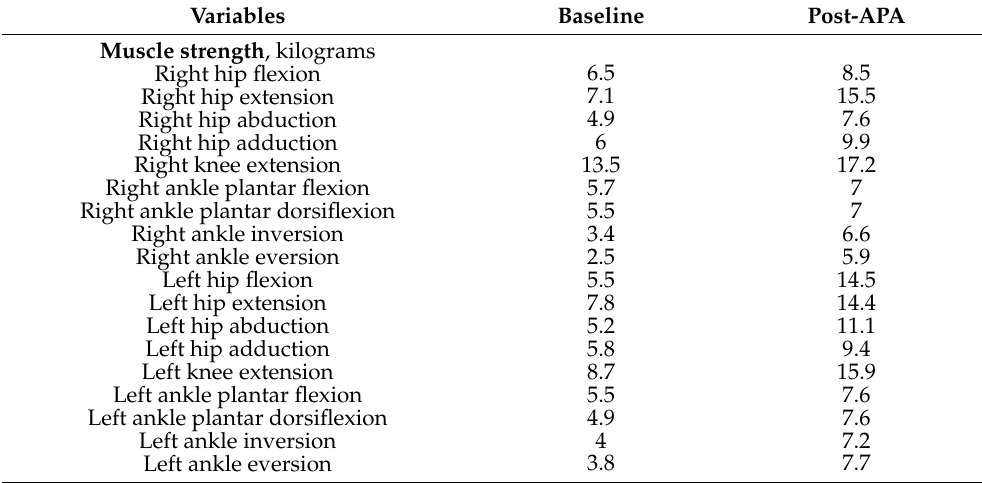
Table 2. Lower limb muscle strength test scores at baseline and post-adapted physical activity protocol.